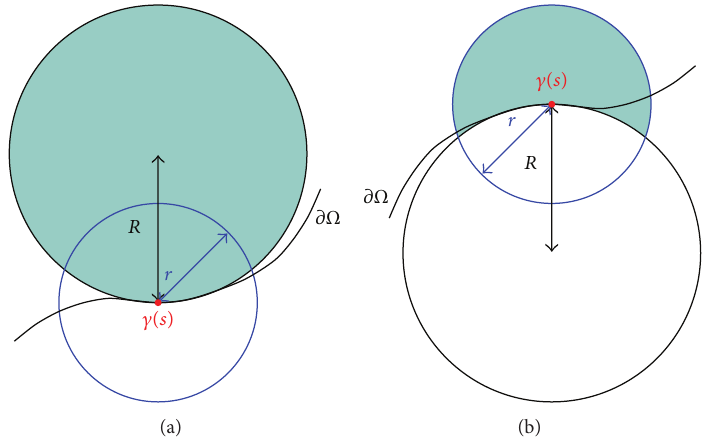
Figure 15: Using the osculating circle as a surrogate for 𝜕Ω in the (a) positive and (b) negative curvature cases.